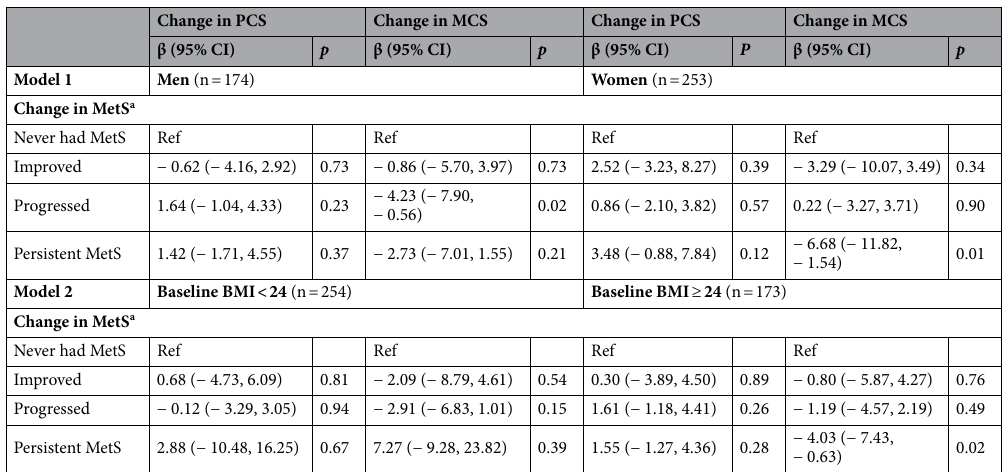
Table 5. The associations of change in metabolic syndrome and change in health-related quality of life, stratified by sex and baseline BMI (n = 427). Model 1 was adjusted for age, marital status, level of education, smoking, alcohol consumption, baseline BMI, and change in physical activity. Model 2 was adjusted for age, sex, marital status, level of education, smoking, alcohol consumption, and change in physical activity. MetS metabolic syndrome, PCS physical component summary, MCS mental component summary, BMI body mass index. a There were 298 (69.8%) participants who never had MetS. 22 (5.2%) participants had an improved MetS status. 66 (15.5%) individuals were categorized as progressed MetS group. 41 (9.6%) subjects had persistent